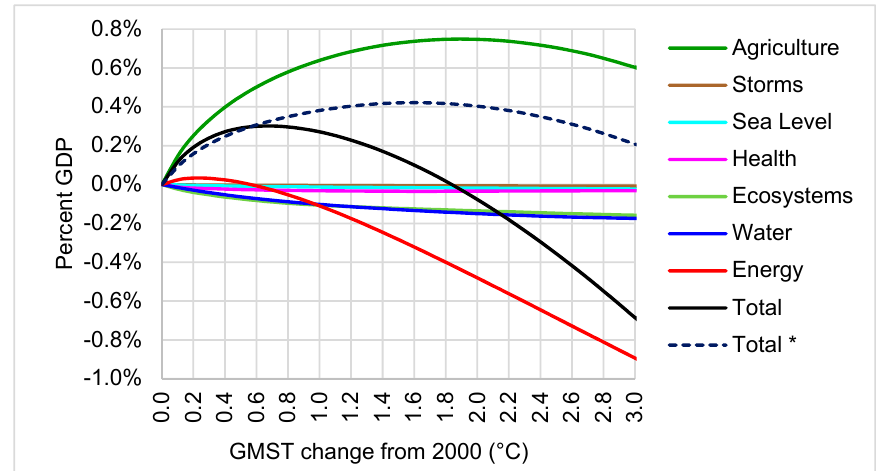
Figure 15. FUND3.9 projected global sectoral economic impact of climate change as a function of GMST change from 2000. Total* is of all impact sectors except